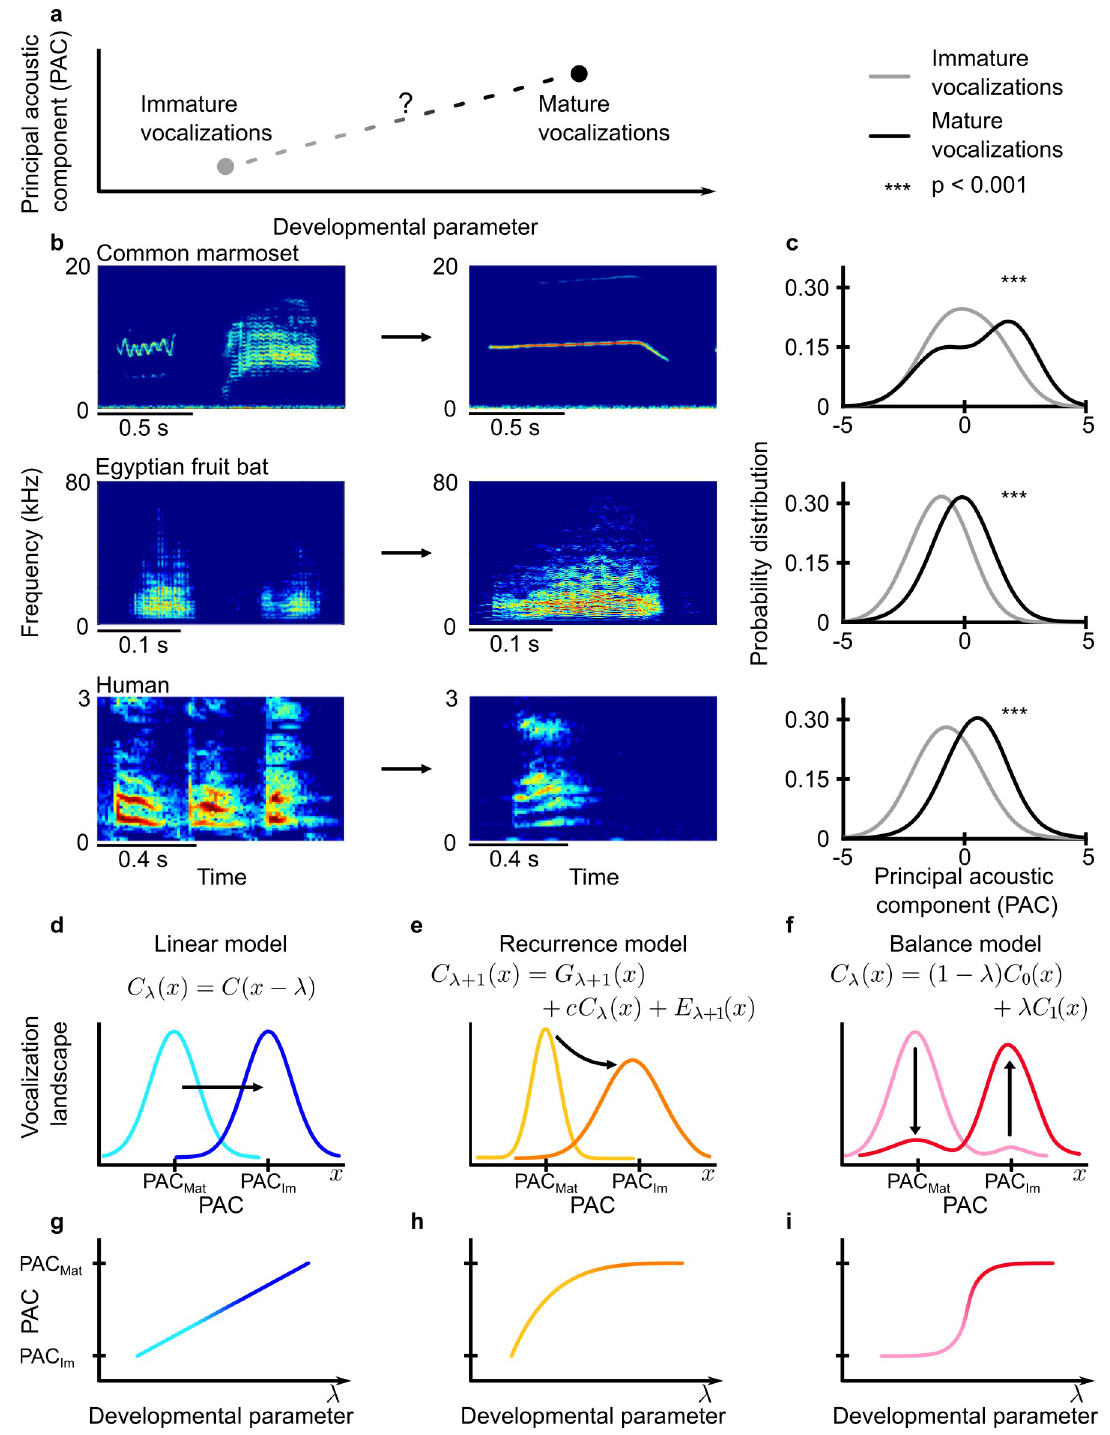
Fig 1. Different models could explain a transition between two developmental states. a. Diagram illustrating one hypothetical transition between immature vocalizations to mature vocalizations. The y-axis is the first component of the PCA performed on the vocalizations and labeled as the Principle Acoustic Component (PAC). b. Sample spectrograms of vocalization for an infant (immature, left) and an adult (mature, right). From top to bottom, we show an example from common marmoset ( Callithrix jacchus ), Egyptian fruit bats ( Rousettus aegyptiacus ), and humans. c. Comparison between the probability distribution of the PACs of immature calls (gray) and mature calls (black). From top to bottom: common marmoset, Egyptian fruit bats, and humans. ��� means p < 0.001. d-f. Dynamics of